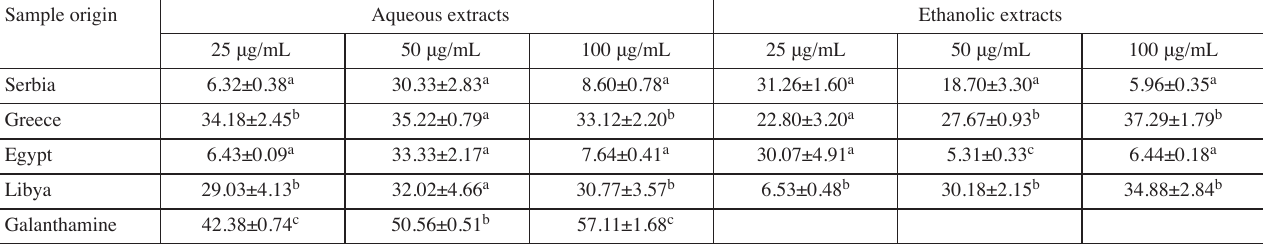
Tab. 6: Acetylcholinesterase inhibitory activity of O. majorana extracts and galanthamine (standard) presented as percentage of AChE inhibition (%) Sample origin